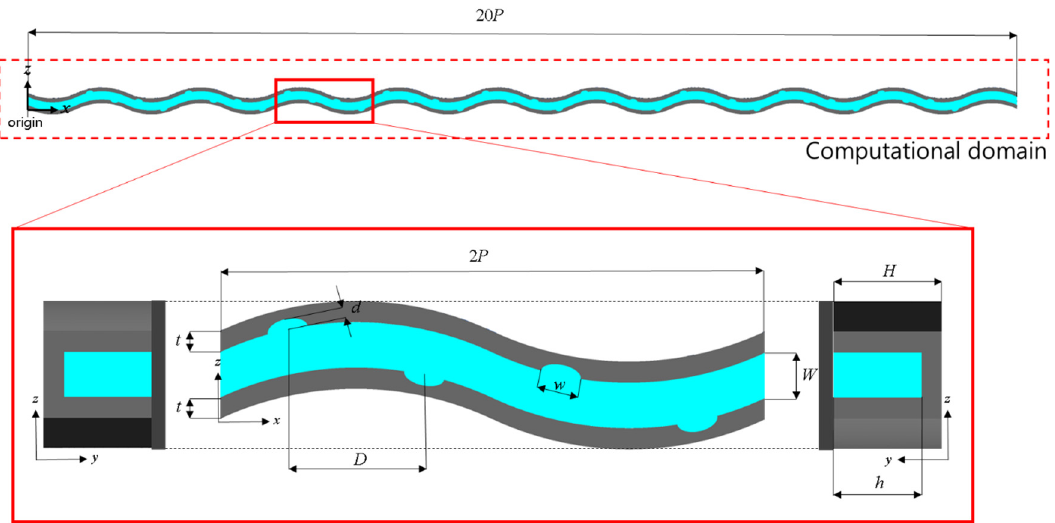
Figure 1. Geometry of the wavy microchannel with grooves and computational domain comprising 10 cycles of wavy channel. Table 1. Dimensions of the reference wavy channel with grooves.